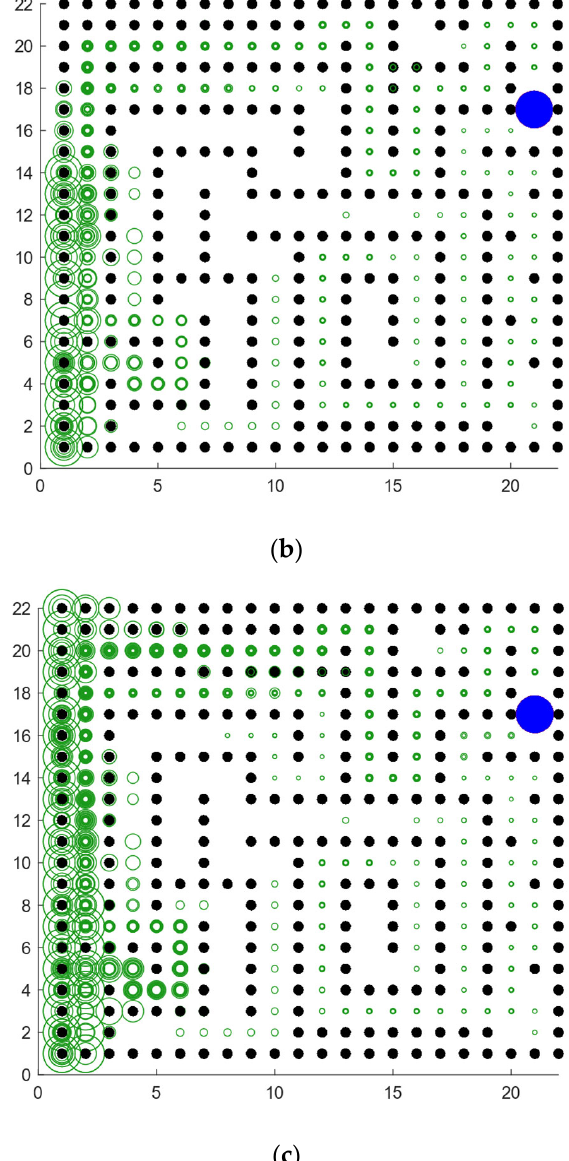
Figure 22. Signal propagation diagrams of our model in a complex maze. The agent starts from the lower left corner of the map (coordinates are (2, 2)) and reaches the blue circle in the upper right corner to get the reward. ( a ) Signal propagation map at the beginning of exploration. ( b ) Signal propagation map for the interim period of exploration. ( c ) Signal propagation map at the later stage of